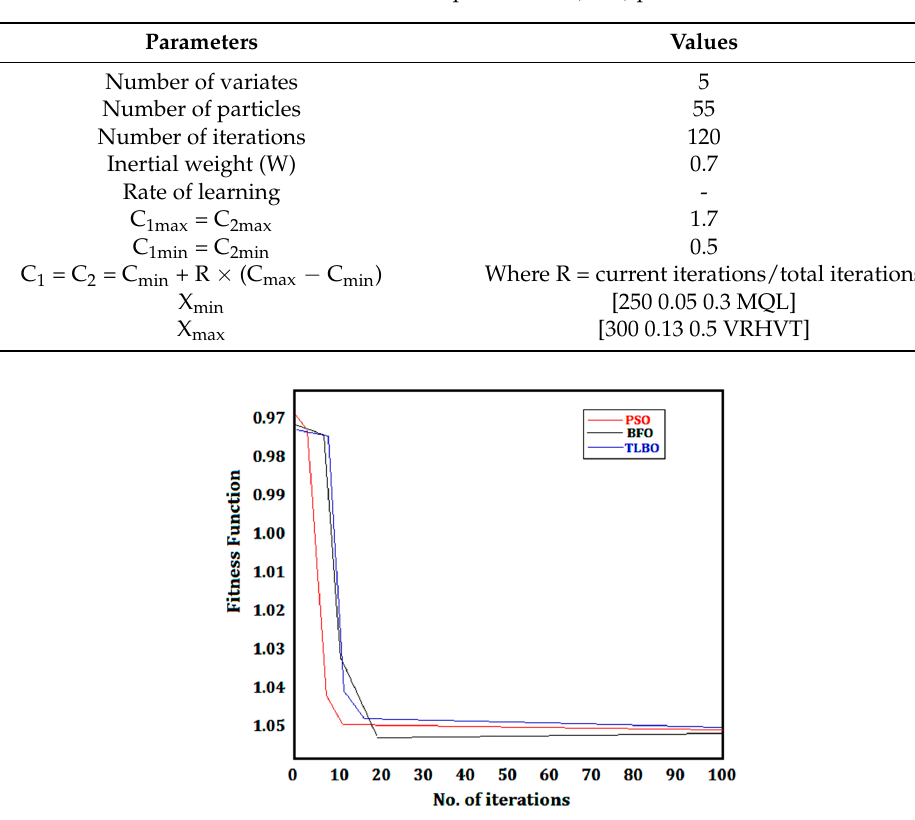
Table 4. Optimized results (desirability approach).